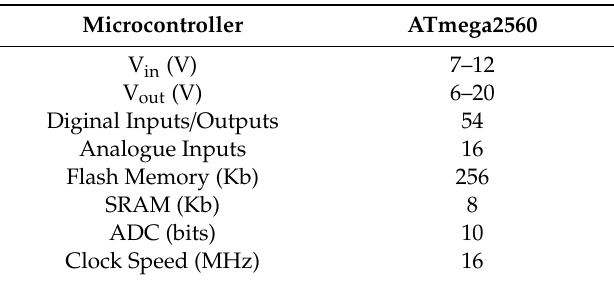
Table 4. Technical data of the Arduino MEGA. SRAM: Static RAM, ADC: Analog Digital Converter.